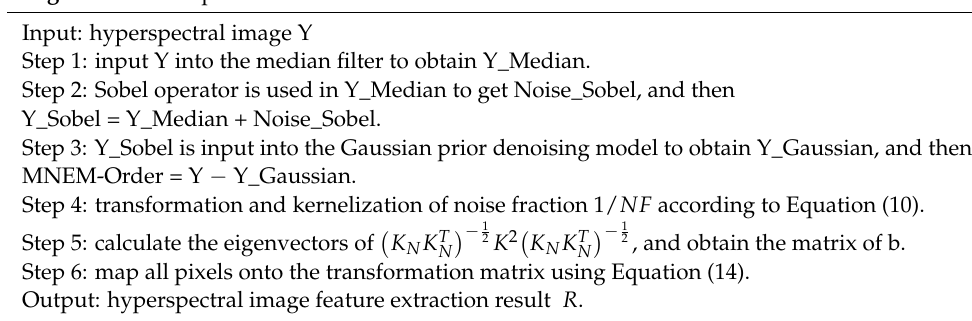
Algorithm 3. The procedure of